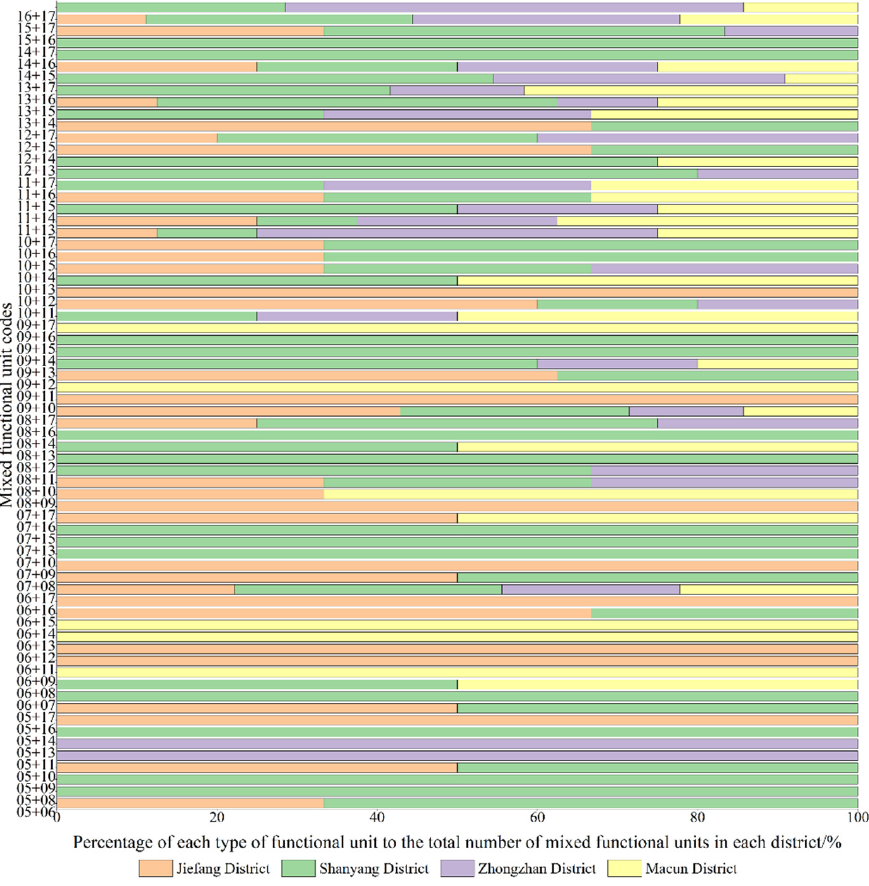
Figure 9. An analysis of the identification results for the mixed functional units in the main urban area in Jiaozuo.